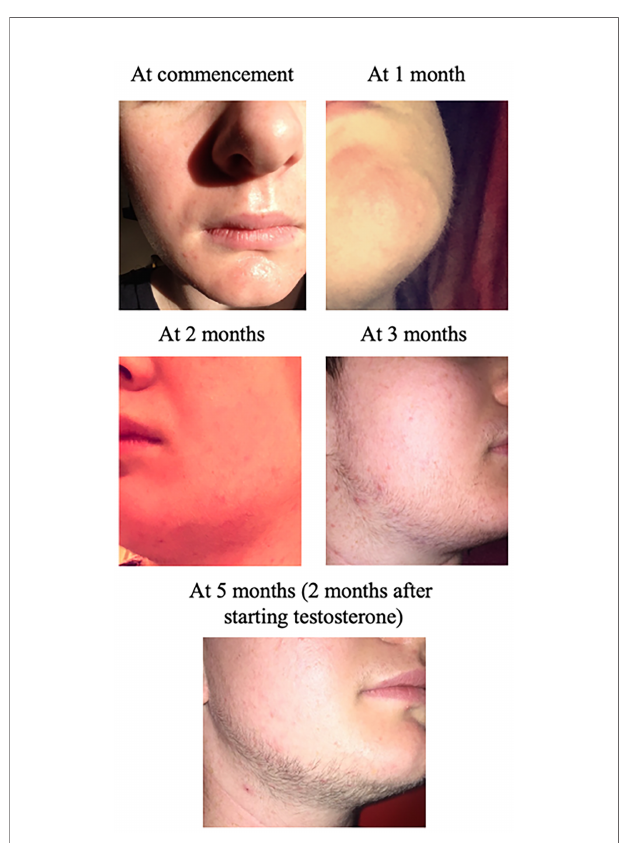
FIGURE 1 | Facial hair growth following topical minoxidil treatment. Minoxidil (5% lotion, 1 mL) was applied twice daily to the beard area. Photos were taken by the patient to document changes in facial hair at the indicated time